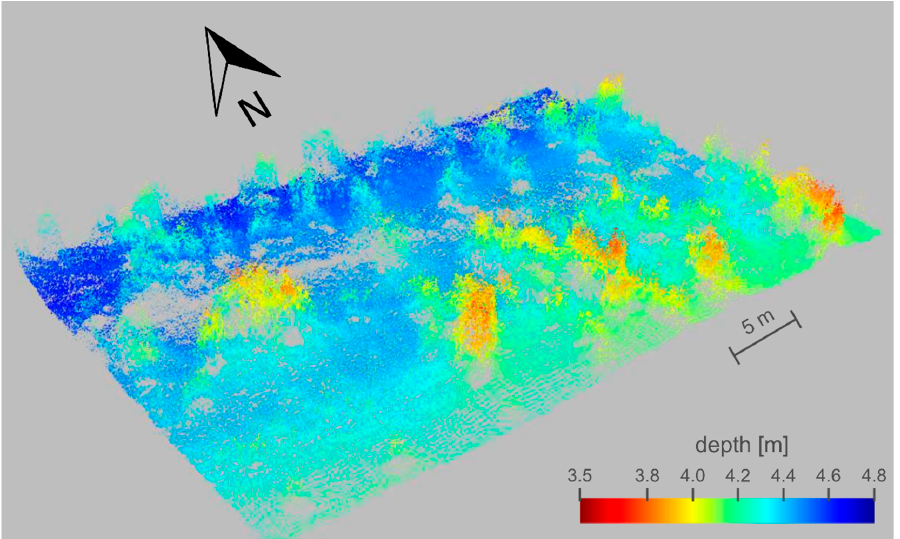
Figure 3. Part of the SA2 multibeam echosounder (MBES) point cloud (PCL), showing seafloor and submerged aquatic vegetation (SAV) patches; Z-exaggeration: 10 x.